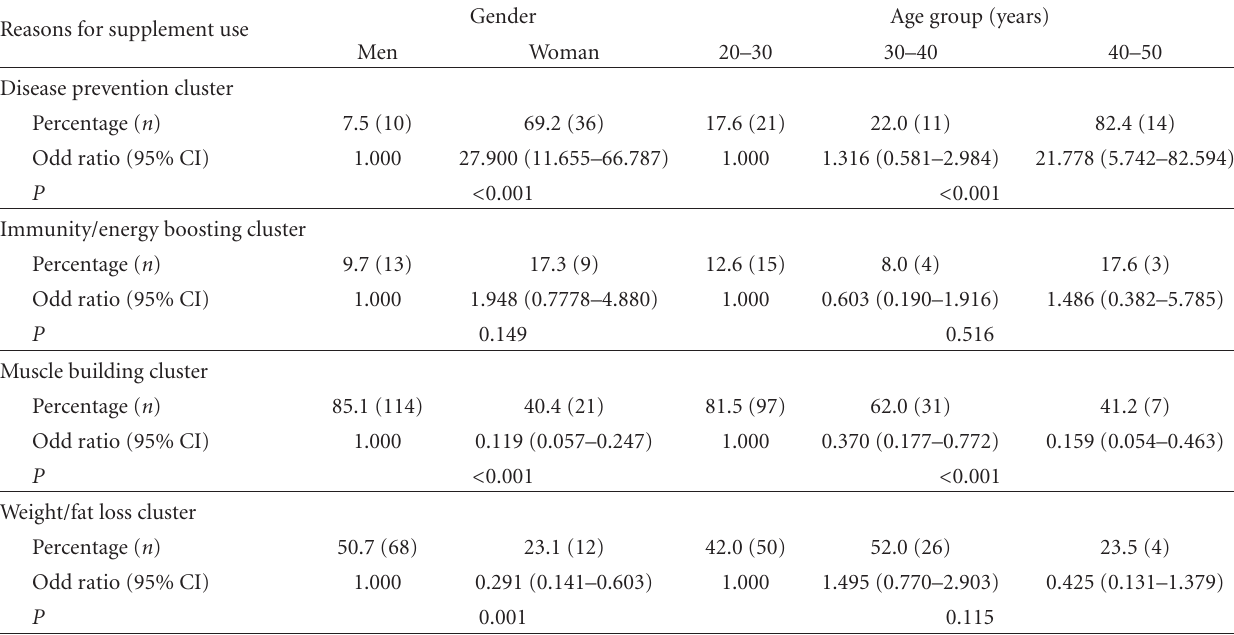
Table 4: Reasons for supplement use by gender and age group ( n = 186).